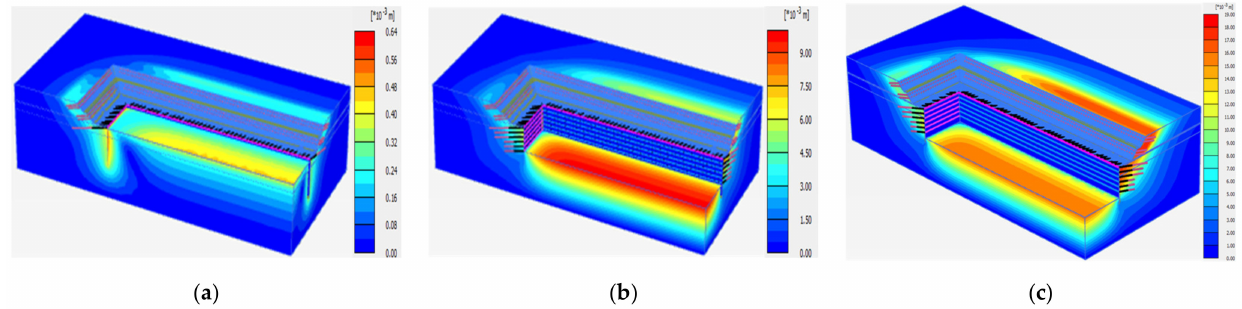
Figure 16. Cloud map of the spatial distribution of pit deformation: ( a ) Case1, ( b ) Case5, ( c ) Case8.